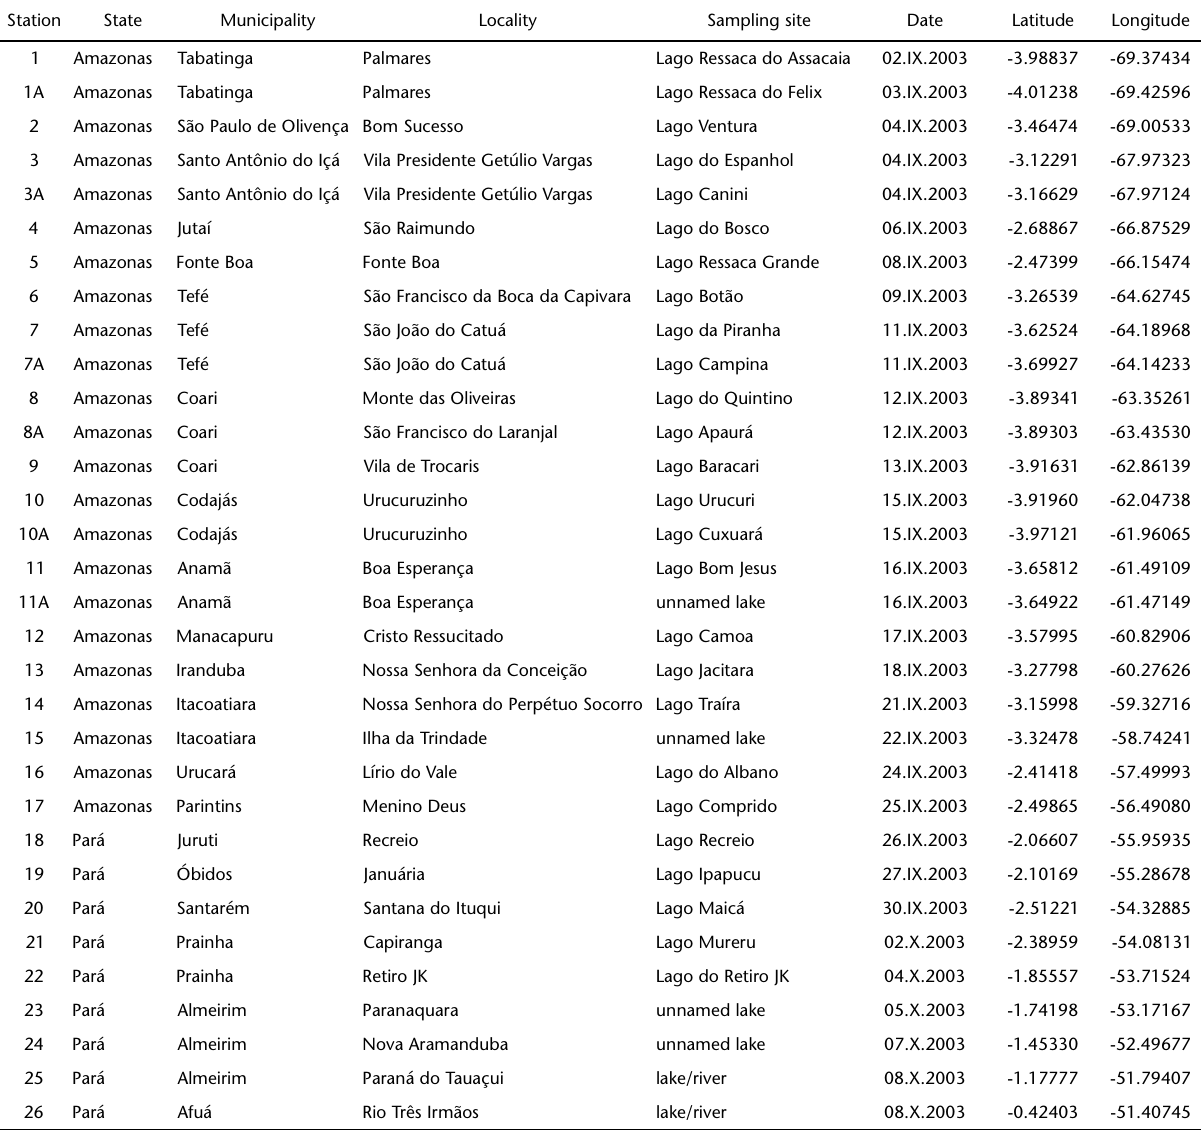
Table I. Location, date and coordinates of the collecting stations along the Amazon River floodplain, Brazil.